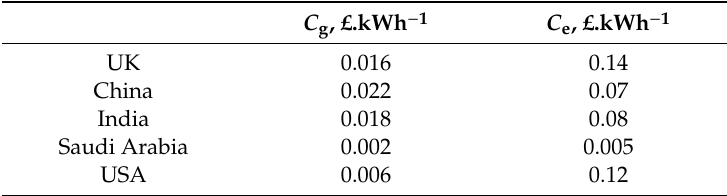
Table A1. Cost of utilities in various global